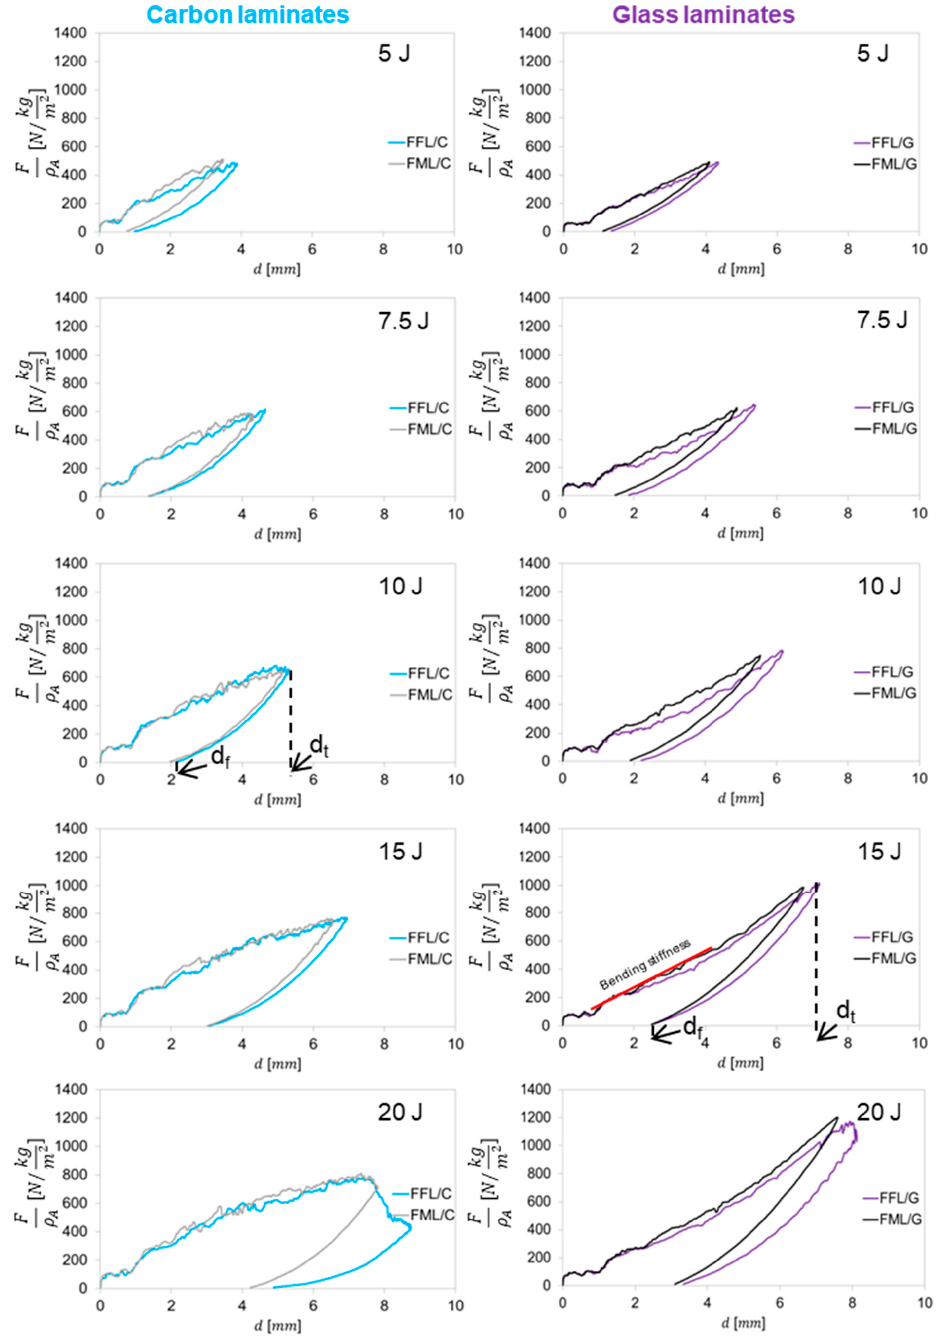
Figure 4. Force–displacement curves of glass and carbon laminates with and without internal foam component.